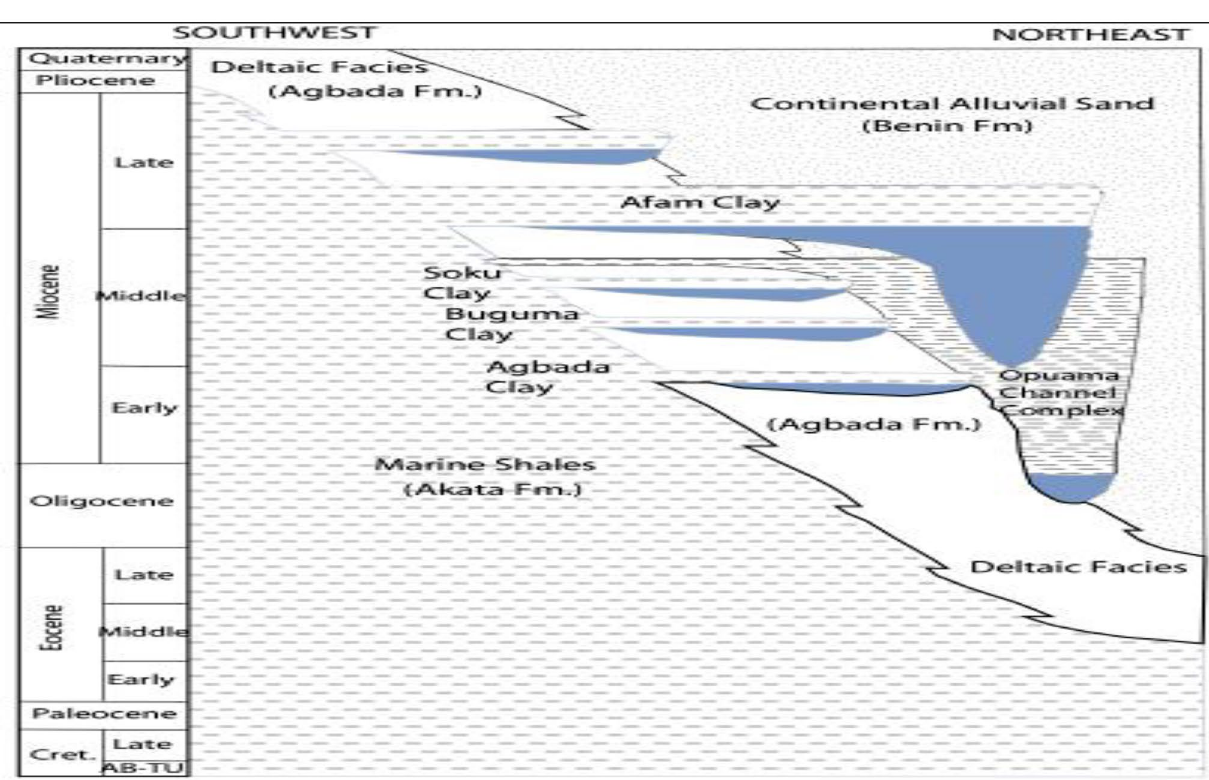
Fig. 2 Depobelts and direction of sediment deposition in Niger delta (Tuttle et al. 1999)